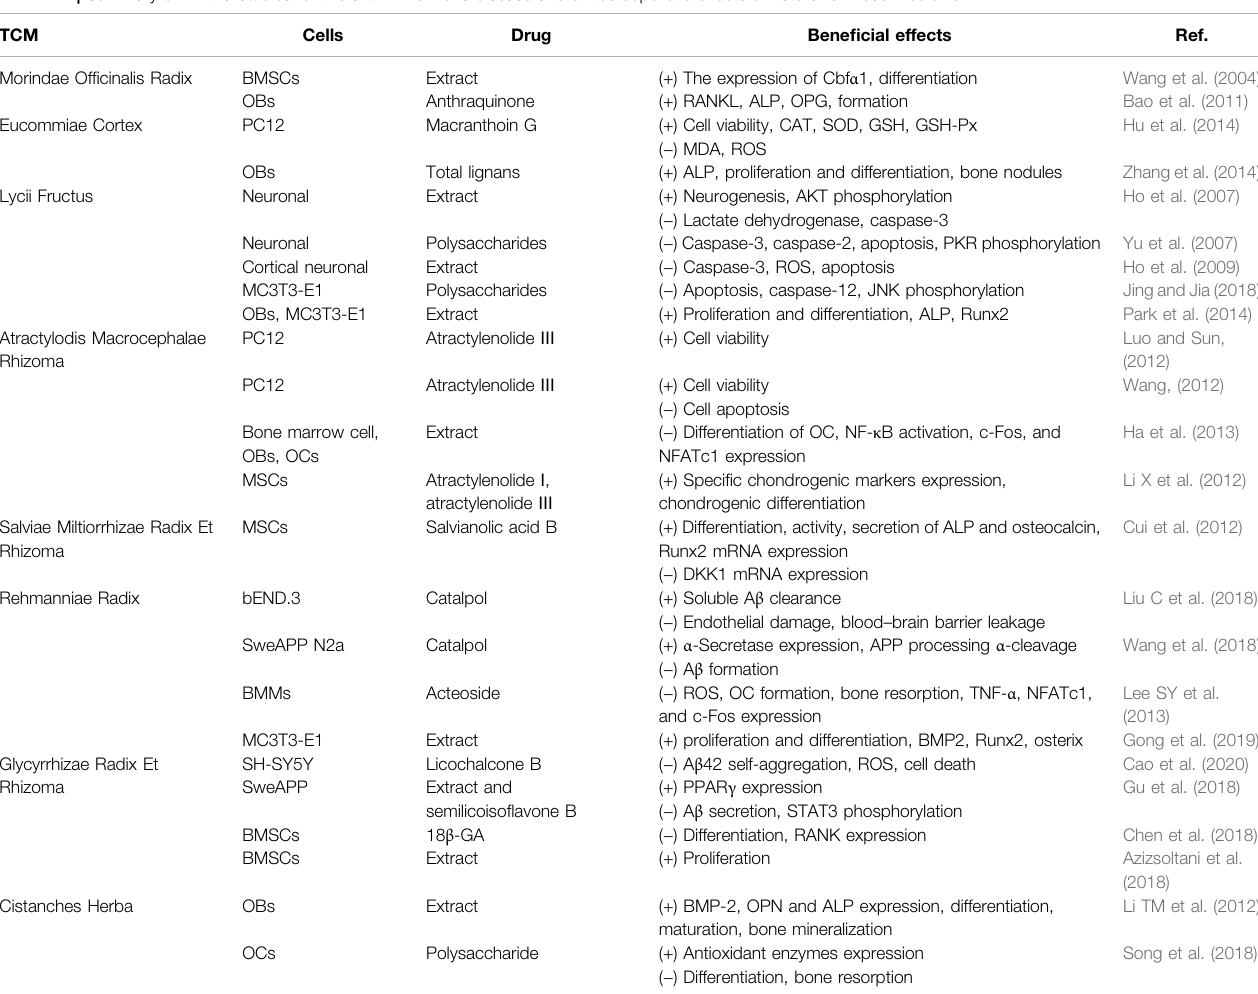
TABLE 2 | Summary of in vitro studies for the anti-Alzheimer ’ s disease and antiosteoporotic effects of natural Chinese